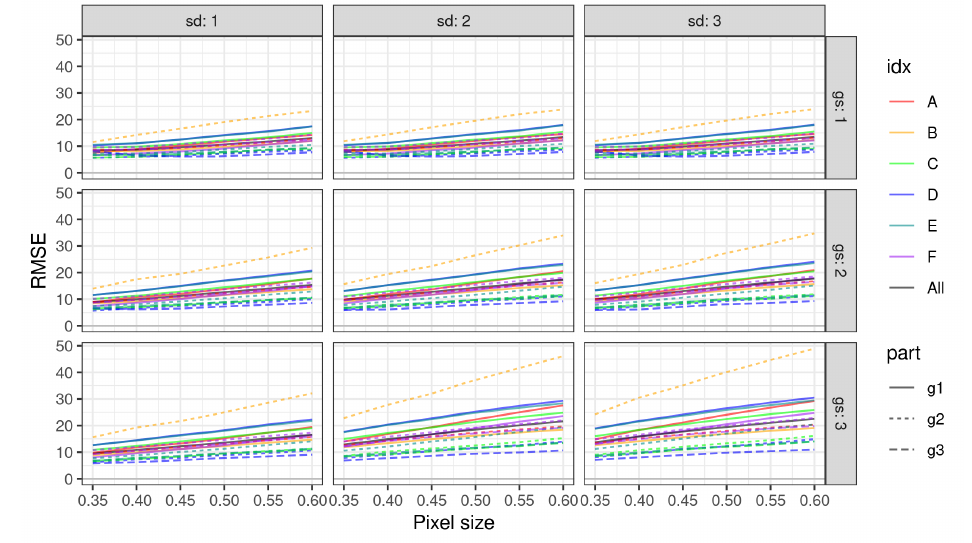
Figure 15. Variability of the RMSE metric as a function of Watershed method parameters—Canopy Height Model (CHM) spatial resolution (pixel size in meters), Gaussian smoothing strength (Gaussian filter window size (gs) and standard deviation (sd) in pixels)—and with respect to groupings of circular plots in different categories (A–F, g1–g3, see Table 2; the ‘All’ group represents the entire set of sample